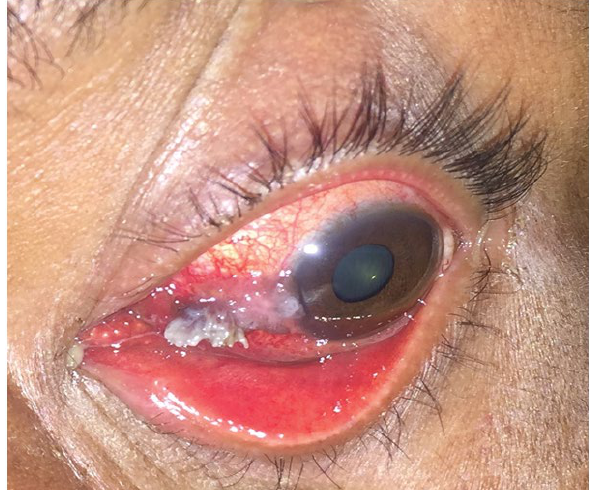
Figure 1: Photograph showing a filiform variant of conjunctival mass in the nasal area with leukoplakic changes encroaching towards the cornea With a differential diagnosis of a HPV associated lesion, pseudoepitheliomatous hyperplasia and actinic disease; excisional biopsy of the lesion, was planned. Also taking the probability of OSSN into consideration, with a non-touch technique, excision of the mass was done under local anesthesia. The mass was sent for histopathological examination which showed intraepithelial neoplasia with high-grade dysplasia (fig. 2). The margins were free of tumor. The patient did not show any signs of recurrence at six months follow up.